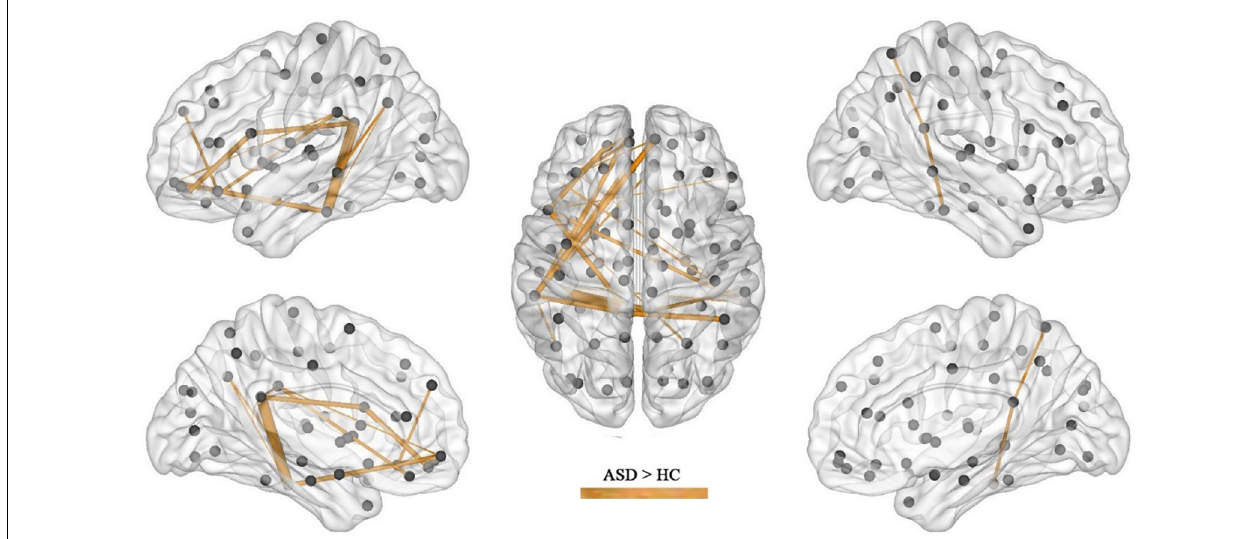
FIGURE 3 | Subnetworks with increased FC in ASD ( p = 0.003).